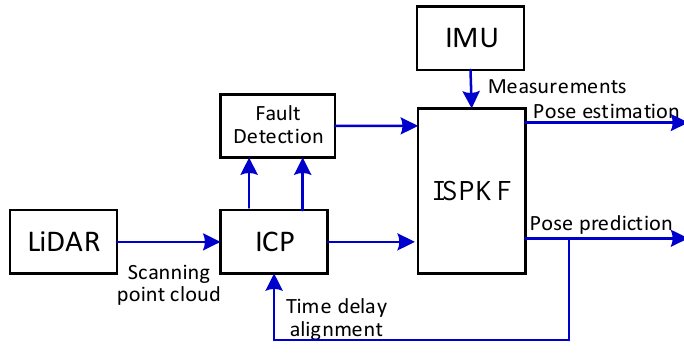
Figure 4. The Architecture of ICP and ISP KF Integration method.